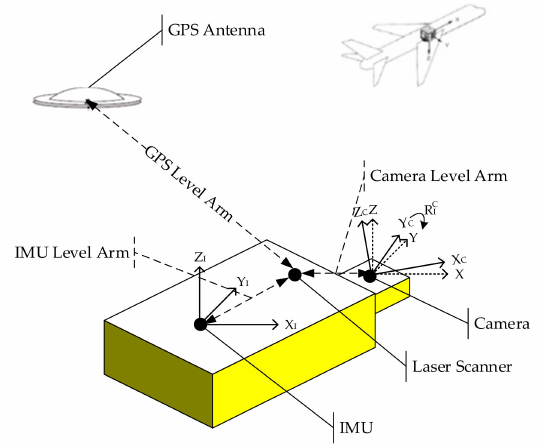
Figure 1. Positional Relationship between Laser Scanner, Camera, GPS, and